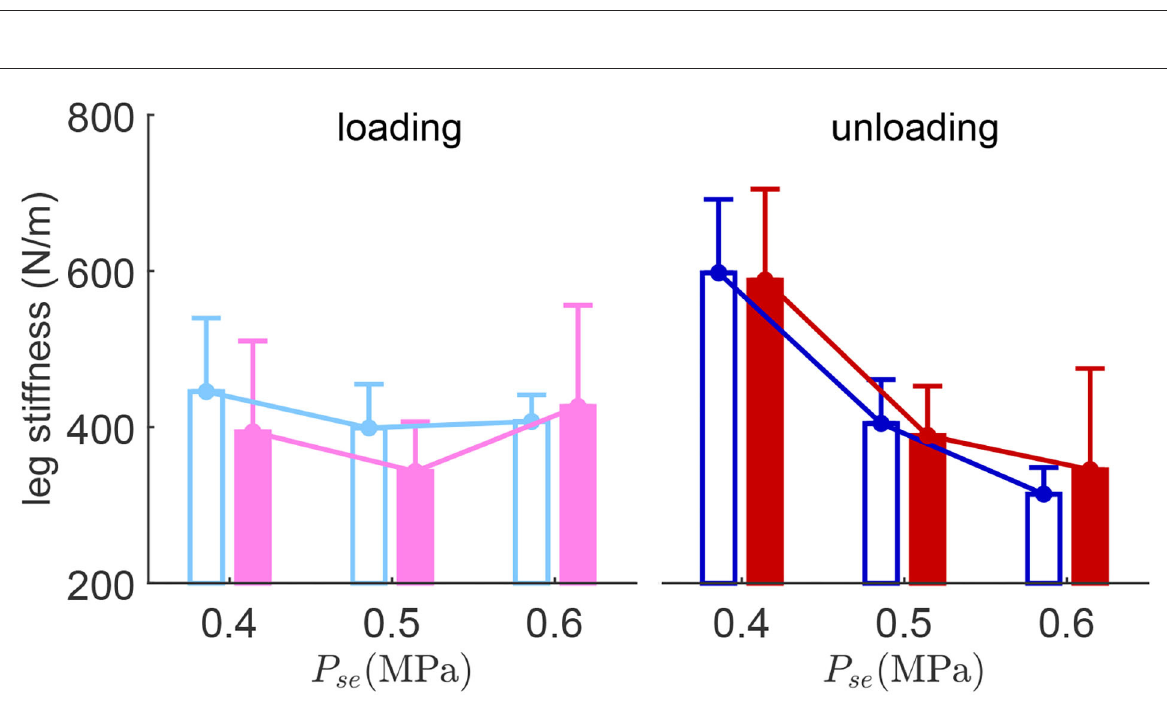
FIGURE5 Leg stiffness during the loading phase (the stance phase when the CoM moving downwards) and the unloading phase (the stance phase when the CoM moving upwards). Error bars denote the SD. Solid and hollow bars denote the perturbed hop and the unperturbed hop (hops before the perturbation) conditions,